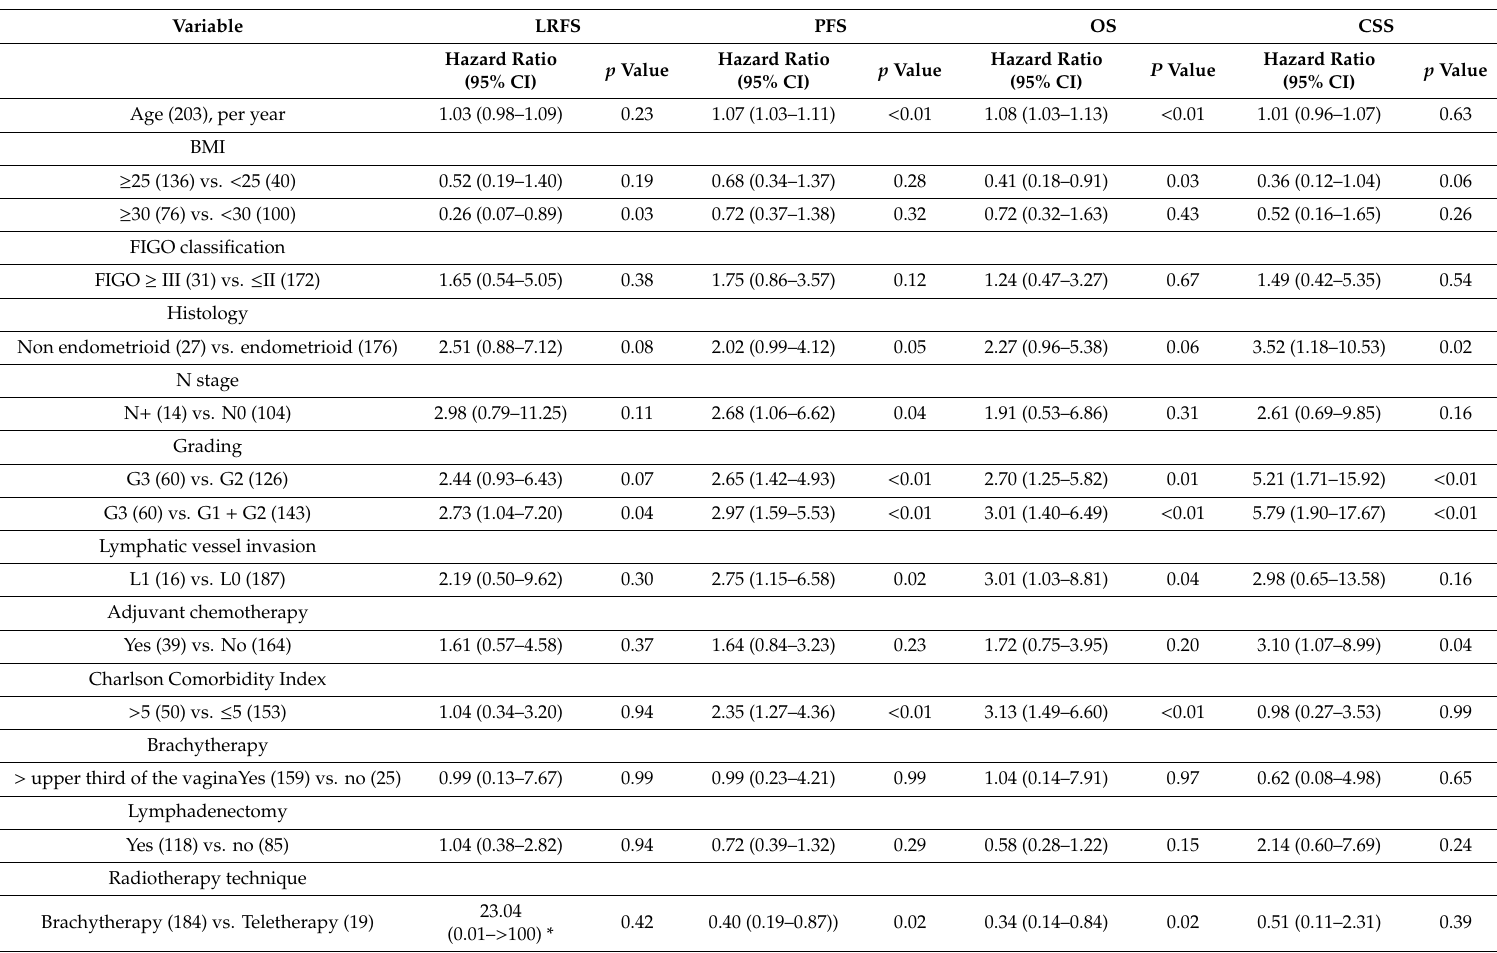
Table 2. Prognosticators in the whole patient cohort, univariable Cox regression analysis. Numbers of patients are indicated in brackets.